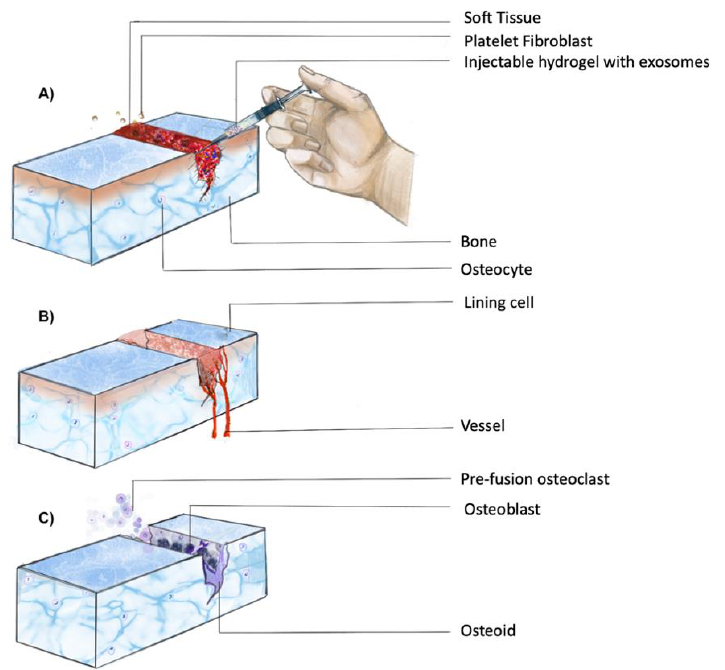
Figure 2. Temporal progression of fracture healing. Healing of a fracture involves a complex series of processes, which can be broadly divided into three phases: ( A ) inflammatory phase; ( B ) soft callus formation; ( C ) mineralization of callus and bone remodeling (adapted from Upadhyay et al. [29]).